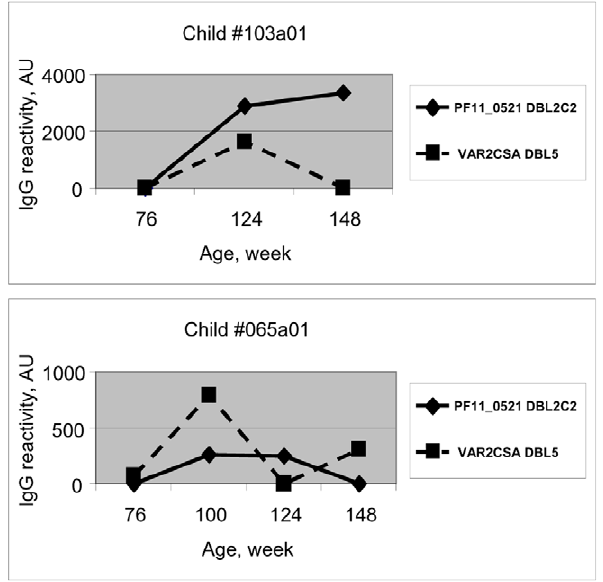
Figure 3. Plasma IgG reactivity to PfEMP1 domains is dynamic over time in individual children. The two panels portray two children as representative examples who experience increases and decreases in plasma reactivity over time against two